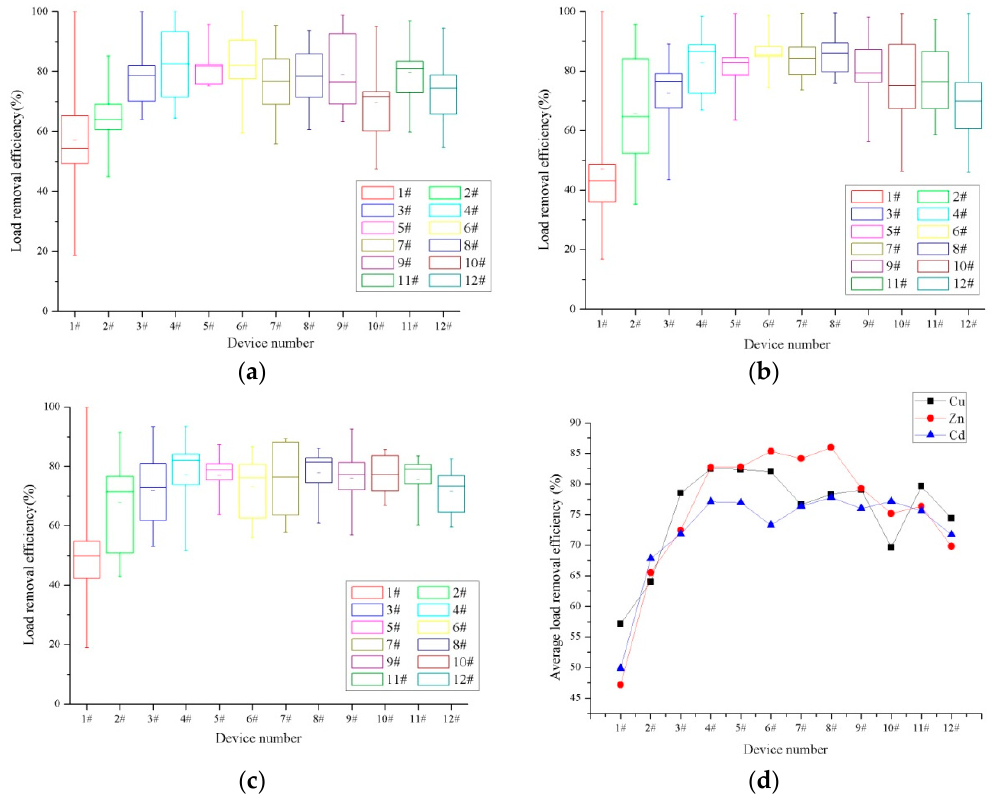
Figure 4. Load reduction efficiency in different media combinations; ( a ) Cu; ( b ) Zn; ( c ) Cd; ( d ) average concentration removal efficiency.